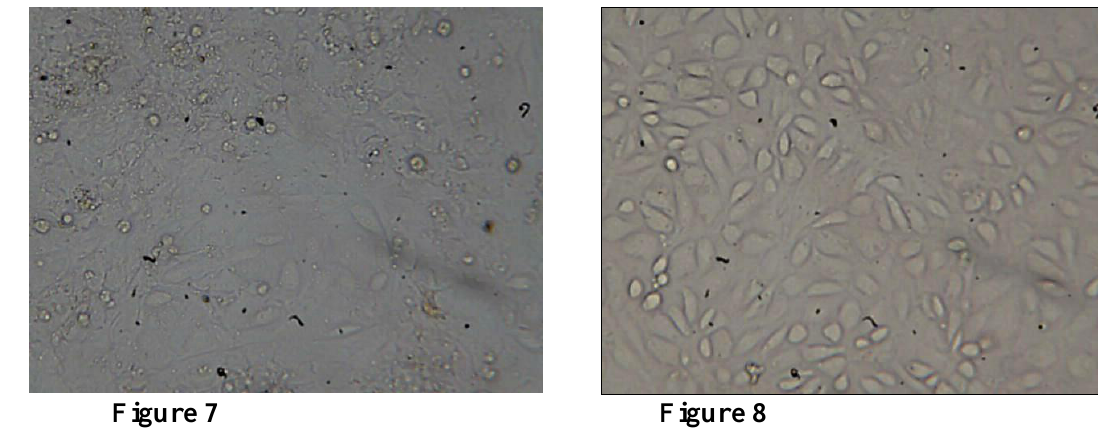
Figure 7: Infected secondary sheep testis cell cultures 100X after 5 days of virus inoculation (3 passages), focal rounding of cells with formation of giant cells Figure 8: normal secondary sheep testis cell cultures 100X. 2-Titration of the isolated virus: The titer of the isolated BPIV-3 in infected SEBK